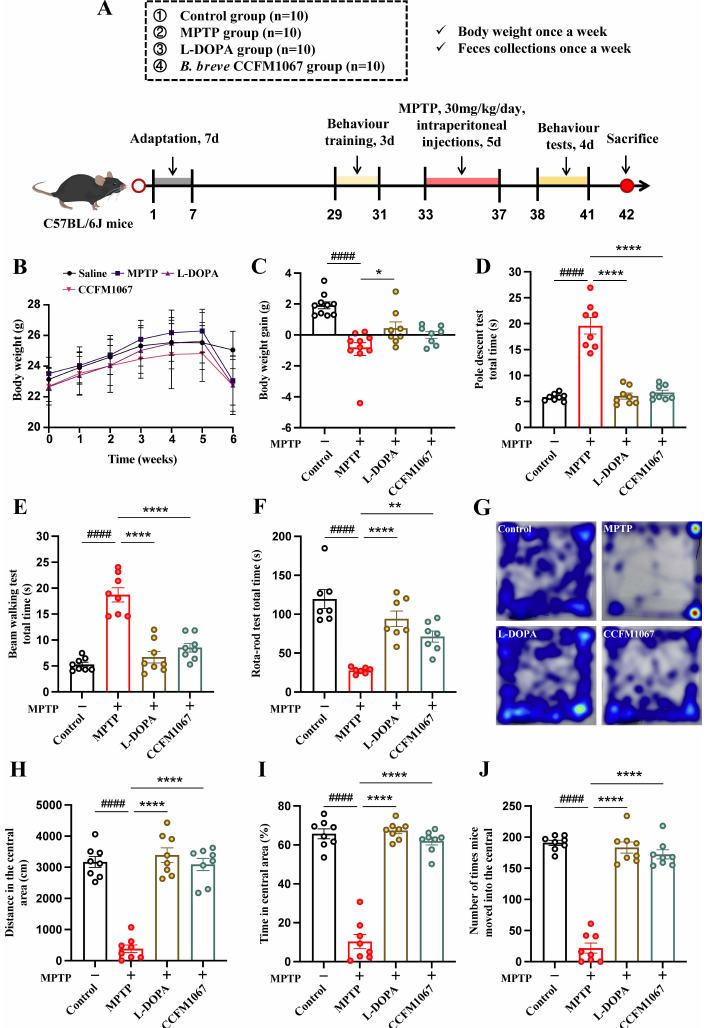
Figure 1. Bifidobacterium breve CCFM1067 alleviated MPTP-induced motor dysfunction in mice. ( A ) Timeline of animal experiments. ( B ) Changes in body weight of mice at six weeks ( n = 10/group).